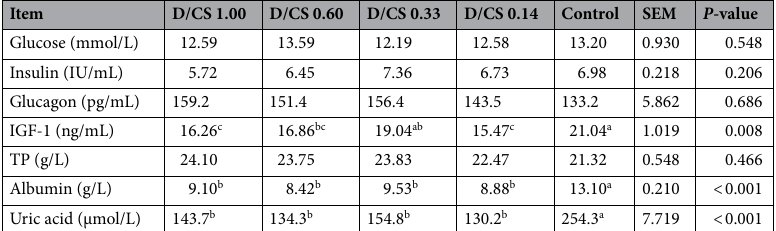
Table 3. The effects of different NFD on serum biochemical parameters of broiler chickens. IGF-1: Insulin- like growth factor-1; TP: Total protein. Values are expressed as the mean and pooled SEM ( n = 6 per group). Different superscript letters in the same row mean significant differences ( P <